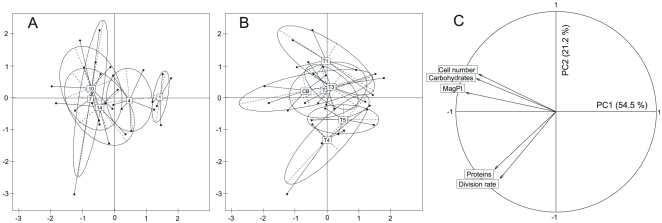
PCA.The projection of the objects in the plane formed by PC1 and PC2 showed that the gravity centers are distributed differently depending on whether they are grouped according to the sampling dates (A) or the treatments (B). (C) Circle of correlation for variables and projection of the variables in the factorial plane PC1 – PC2.